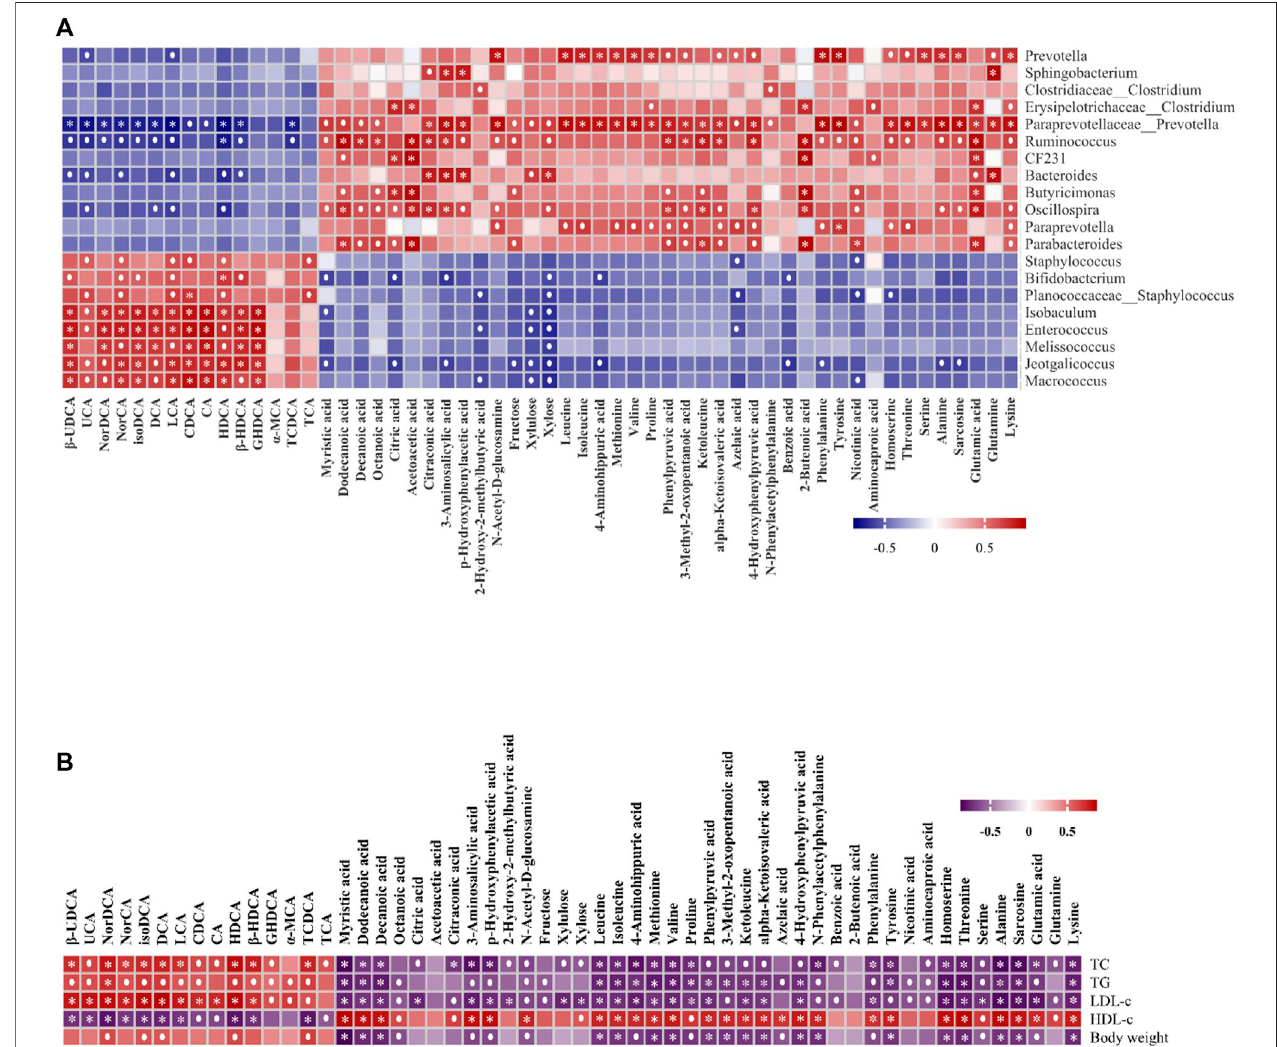
FIGURE 5 | The Spearman ’ s correlation analysis of gut microbiota, metabolic parameters, and metabolites. (A) Correlations of 56 altered metabolites and fi ve metabolicparametersinHFDandHFD+FRRTusingSpearmancorrelationanalysis. (B) Correlationsof56altered metabolitesand20alteredgutmicrobiota inHFDand HFD + FRRT using Spearman correlation